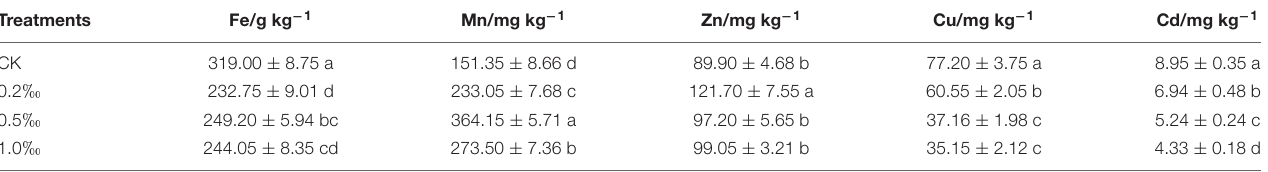
TABLE 3 | The concentration of metals in the root of rice. Treatments